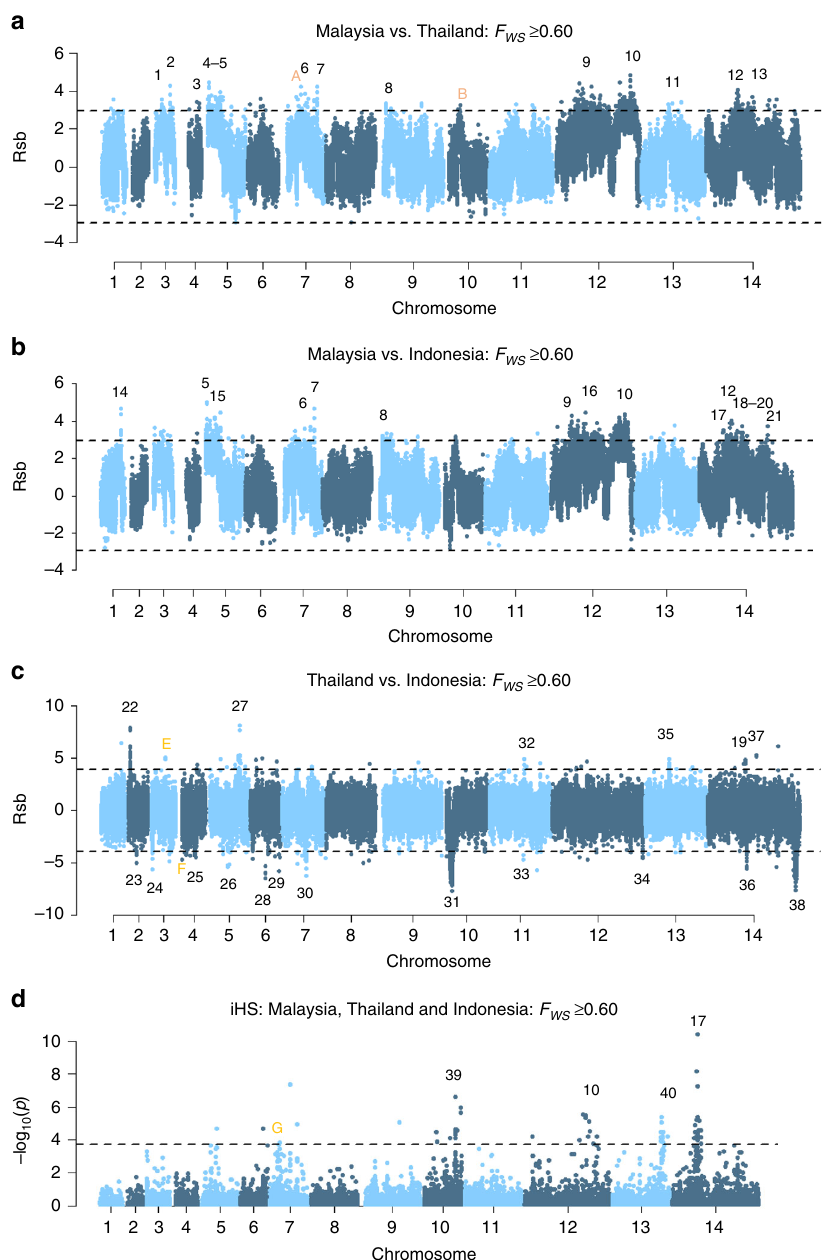
Fig. 5 Genome-wide scans to identify regions with extended haplotype homozygosity using low-complexity samples. a – c Manhattan plots of the Rsb index for the given populations, and d the iHS p value for the pooled populations. Analyses were conducted on low-complexity samples ( F WS ≥ 0.60). The dashed black lines demark the top 0.5% SNPs with the most signi fi cant p values. Regions with ≥ 3 SNPs within 80 kb of one another and overall SNP density <10 kb per SNP amongst the top 0.5% SNPs are numbered in black. Several previously described signals in known or putative drug resistance candidates were identi fi ed including DHPS (region 19), DHFR-TS (region 27) and MRP1 (region 22) 10 – 13 . A previously described signal on chromosome 10 (region 31) is downstream of MDR1 11 . The signal in region 10 re fl ects the highly homologous region on chromosome 12. Putative genetic drivers in the chromosome 12 region are MDR2 13 , GEST and HDP, but the latter has no directly supporting SNPs. Other drug resistance candidates include nucleoside transporter 2 and folate transporter 1 in regions 4 and 5, drug/metabolite transporter 1 ( DMT1 ) in region 12, CG2-related protein in region 21, a previously described voltage- dependent anion-selective channel (region 35) 11 , and plasmepsin IV in region 40. The putative drivers in regions 3, 7, 9 and 39 include several merozoite surface proteins: MSP5 , MSP1 , MSP7 -like gene cluster and MSP3.2 , respectively 12,26 . Another surface protein presenting a putative driver is the duffy-binding protein in region 29. In other gene classes, candidate drivers include zinc fi nger protein (region 6), calcium/calmodulin-dependent protein kinase (region 8), fi lament assembling protein (region 14), Plasmodium exported proteins (region 15), an AP2 domain transcription factor (region 17) 13 , DNA-binding protein (region 23), 3 ’ exonuclease (region 25) and JmjC domain-containing protein (region 36). The putative genetic drivers in regions 13, 18, 24, 28, 34 and 38 have unknown function, and those in regions 1, 2, 11, 16, 20, 26, 30, 32, 33 and 37 remain unclear. Orange letters indicate regions with 1 – 2 SNPs amongst the top 0.5% SNPs that were represented by ≥ 3 SNPs in the monoclonal samples ( F WS ≥ 0.95) and are detailed in Supplementary Fig.